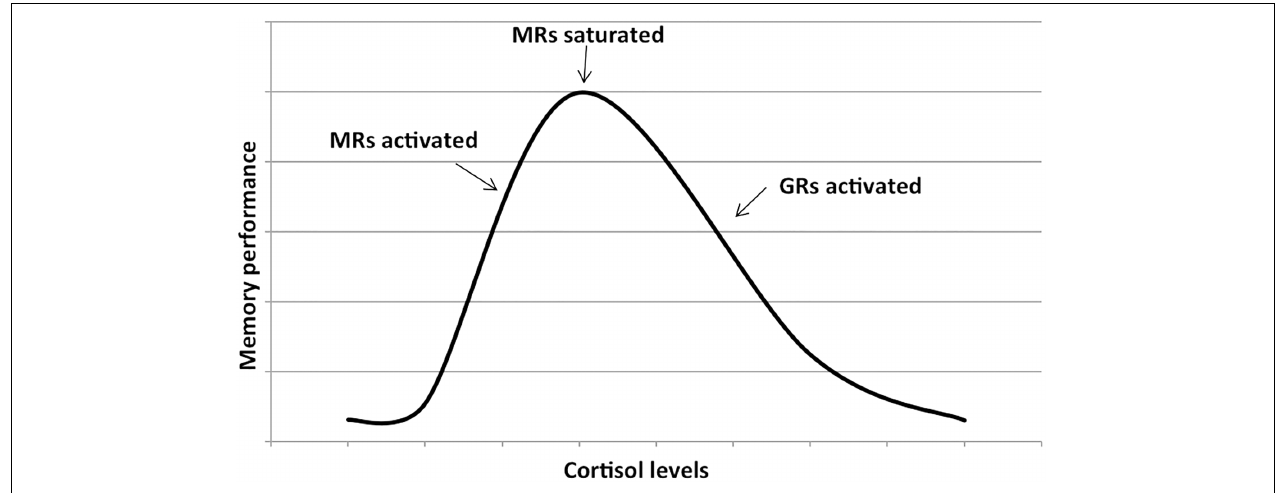
FIGURE 1 | Dose–response relationship between the memory performance and the cortisol levels. The first part of the plot shows that memory performance increases as cortisol levels increase (due to the activation of mineralocorticoid receptors or MRs). As soon as the MRs are saturated, further increase in cortisol levels activates the glucocorticoids receptors or GRs and memory performance decreases. Adapted with permission from Lupien et al. (2007).